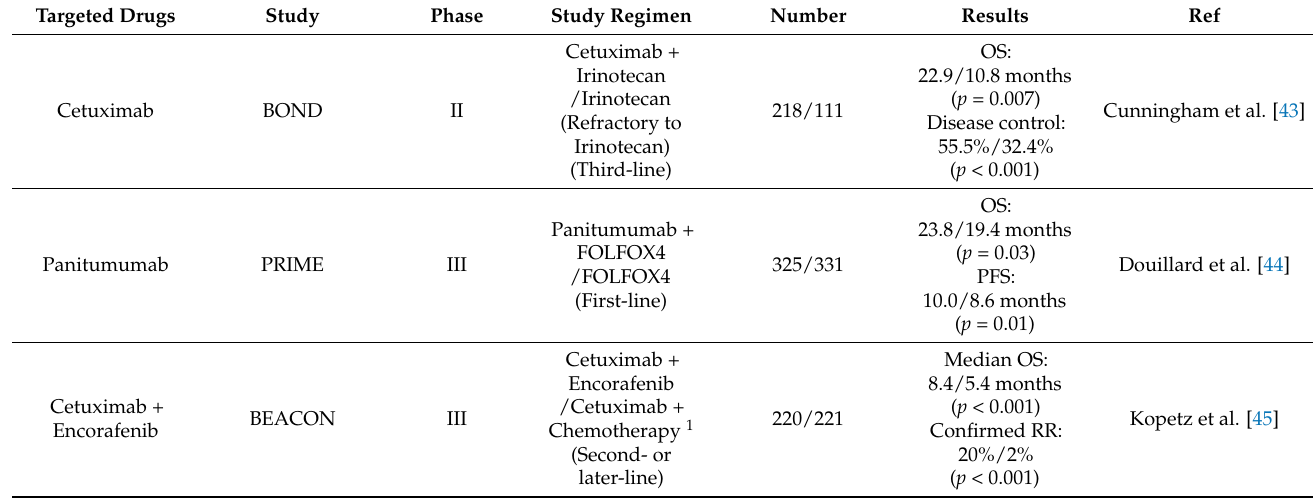
Table 2. Selected clinical trials for EGFR ( ± BRAF)-targeting